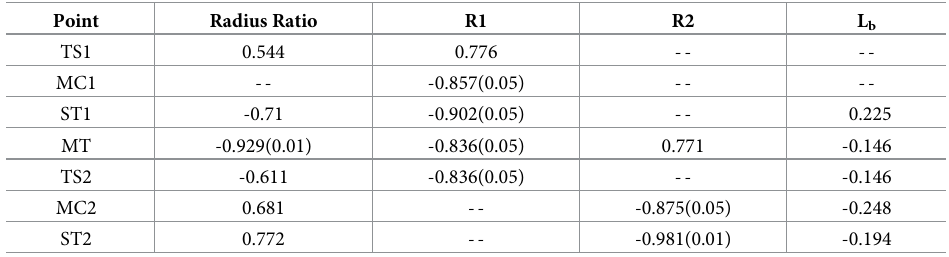
Table 6. Correlation analysis of D of adjacent curves in one direction